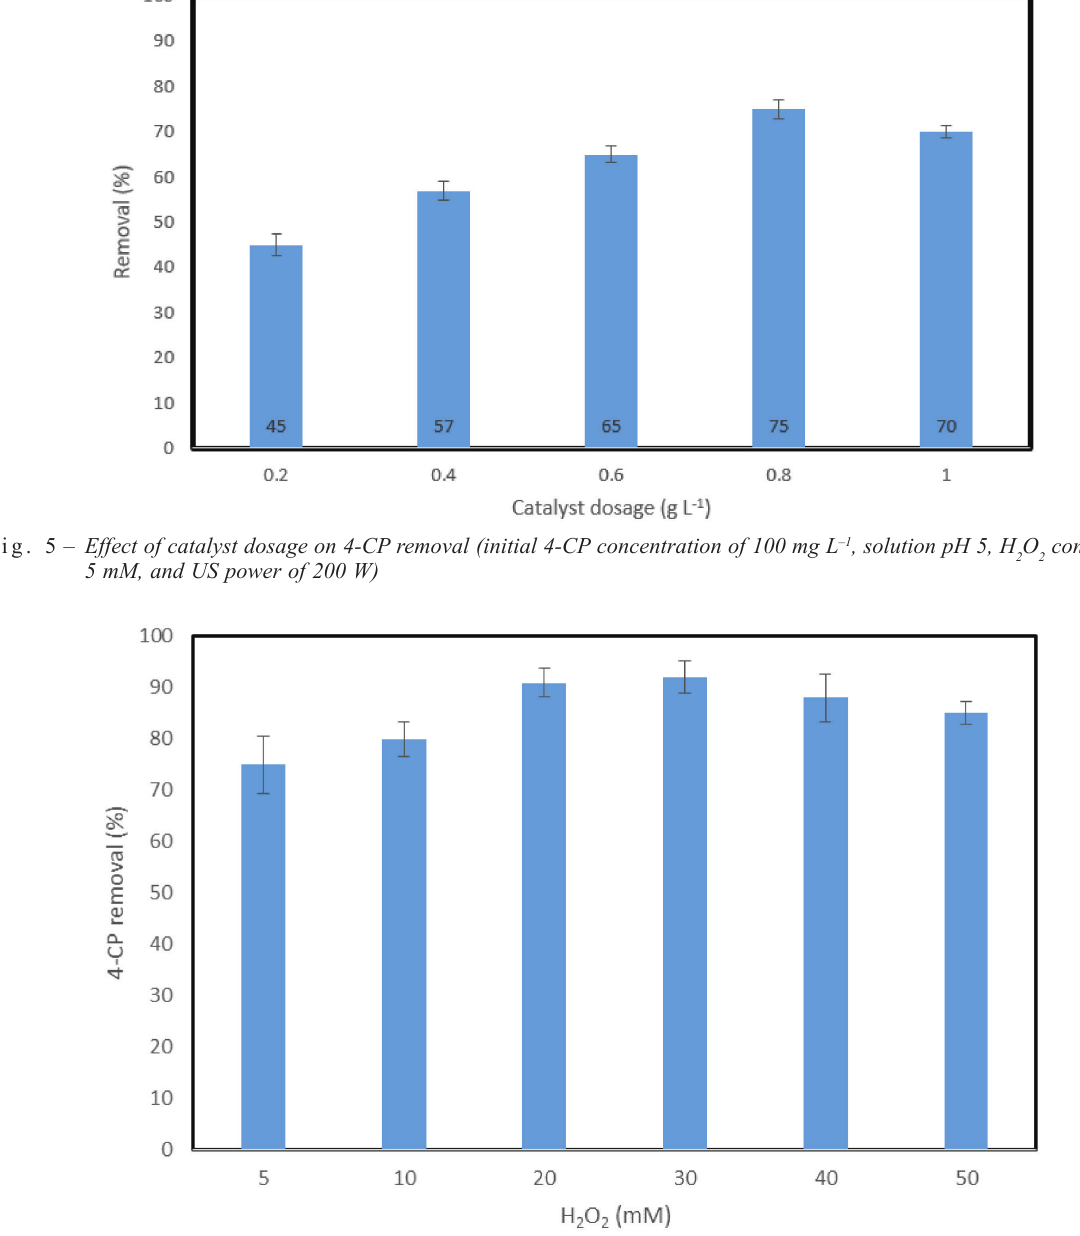
O dosage on 4-CP removal (initial 4-CP concentration of 100 mg L –1 , solution pH 5, catalyst dosage 0.8 g L –1 , Fig. 6 – Effect of H 2 2 and US power of 200